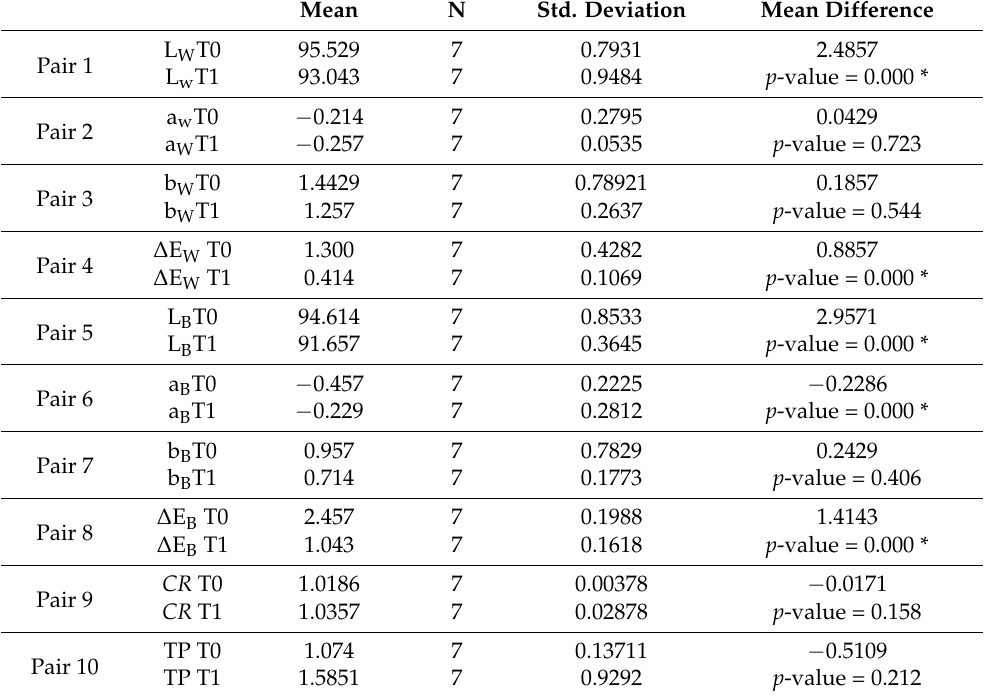
Table 4. Paired sample statistics (1350 ◦ C). Mean N Std. Deviation Mean